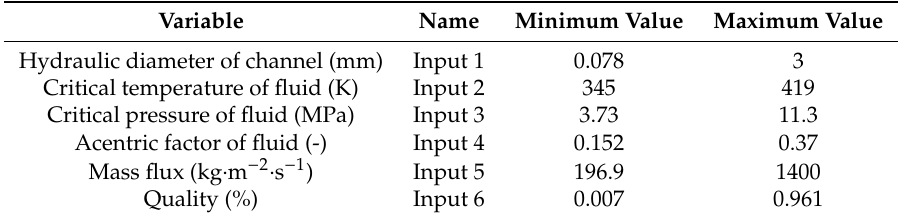
Table 1. Range of the input